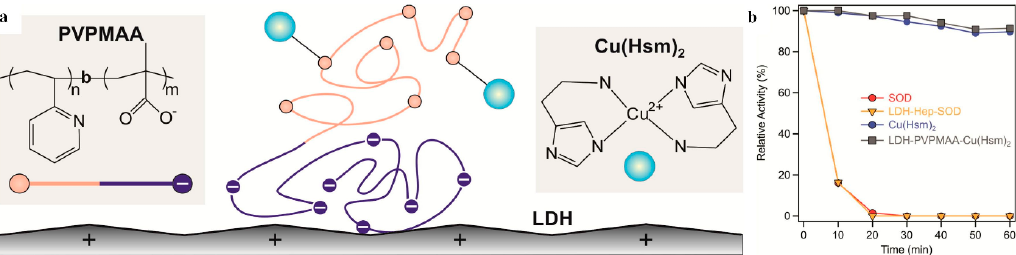
Figure 10. Schematic representation of formation of Cu(Hsm) 22+ on PVPMAA-coated LDH ( a ) and its activity in SOD assay compared to bare SOD, LDH-Hep-SOD and Cu(Hsm) 22+ at 80 °C as a function of reaction time ( b ). Reprinted from (Highly stable enzyme-mimicking nanocomposite of antioxidant activity, 543, Pavlovic, M.; Nafradi, M.; Rouster, P.; Murath, S.; Szilagyi, I., Journal of Colloid and Interface Science 2019, 543 174–182) Reference [124] Copyright (2020), with permission from Elsevier.